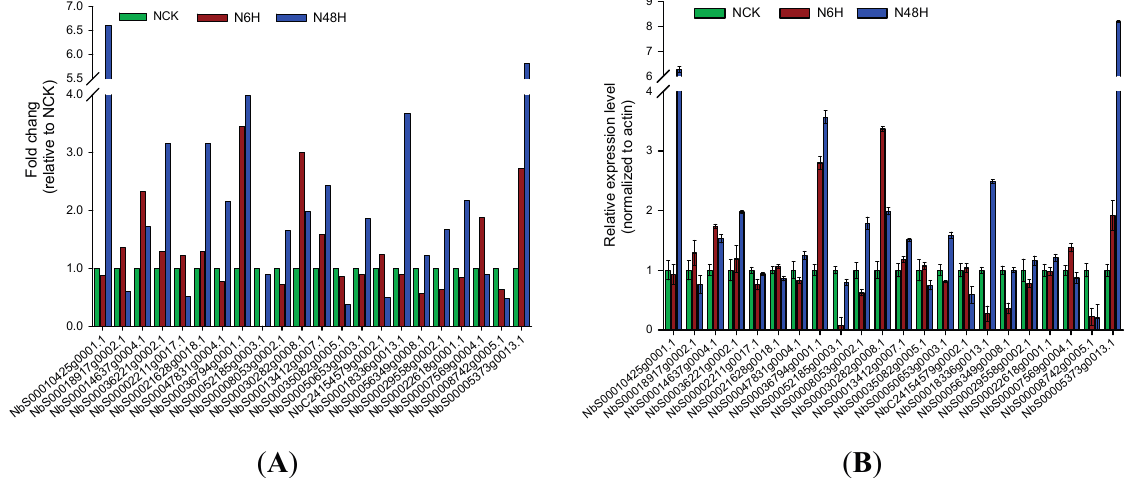
Figure 2. Expression of 22 genes in control and drought-treated roots of tobacco. ( A ) The levels of 22 genes detected by Solexa sequencing in three Digital Gene Expression (DGE) libraries (NCK, N6H and N48H); ( B ) The levels of these 22 genes detected by quantitative Real-Time PCR (qRT-PCR) in NCK, N6H and N48H (normalized to actin; n = 3). The green, purple and blue bars in graph B depicted the qRT-PCR relative expression level ± standard error of three replicates for each gene in NCK, N6H and N48H, respectively. NCK, N6H and N48H represented three samples of tobacco roots at 0 h (control, without drought-treatment) and two drought-treatment time-points (6 and 48 h),